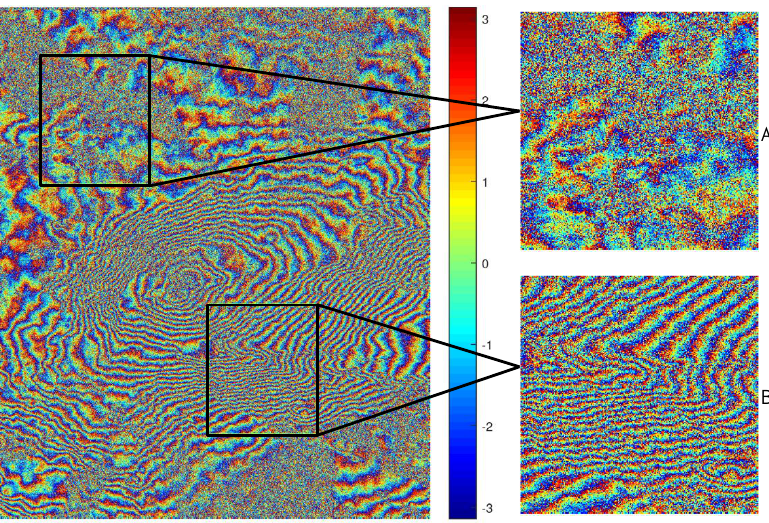
Figure 16. SIR-C/X-SAR data: a real interferometric phase image and its a low coherence area (labeled A) and a high coherence area (labeled